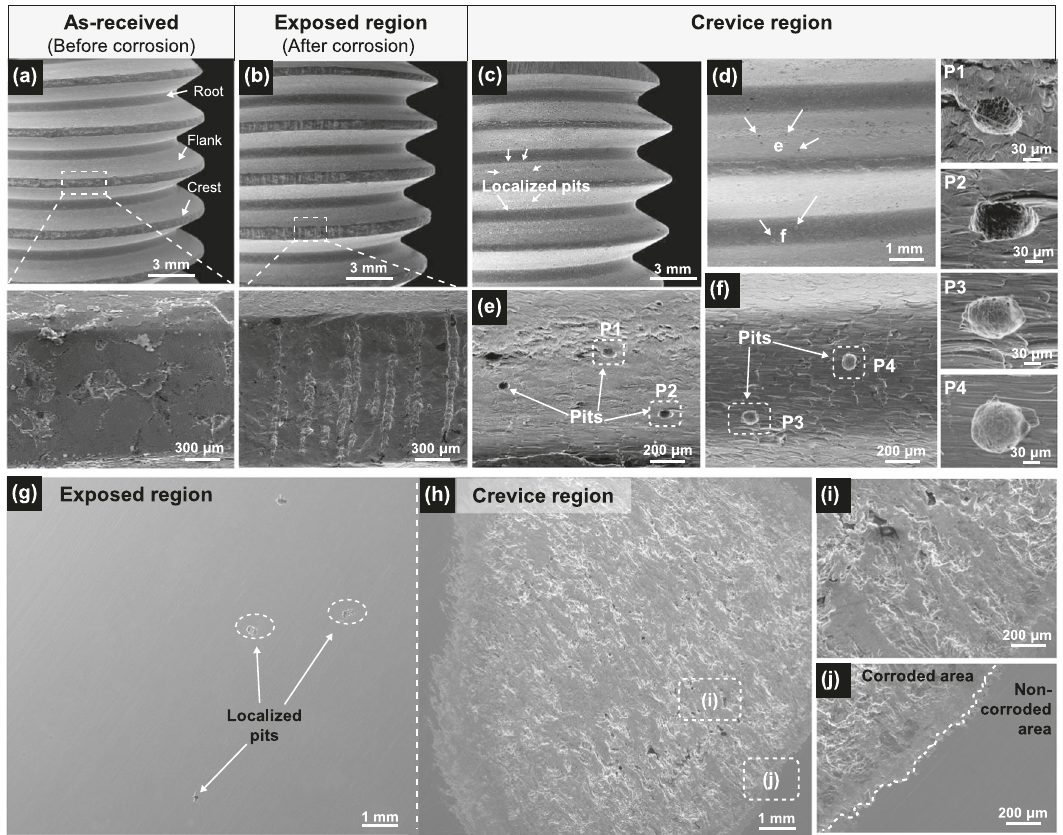
Fig. 1 Surface morphologies of the 304SS threaded and planar fastener specimens. a As-received specimen, b exposed region after corrosion test, c crevice region after corrosion test, d enlarged view of the crevice region, e sampled area at the fl ank, f sampled area at the root, g exposed region of planar specimen, h crevice region of planar specimen, i enlarged view of the area labelled ‘ i ’ within the crevice region, and j enlarged view of the area labelled ‘ j ’